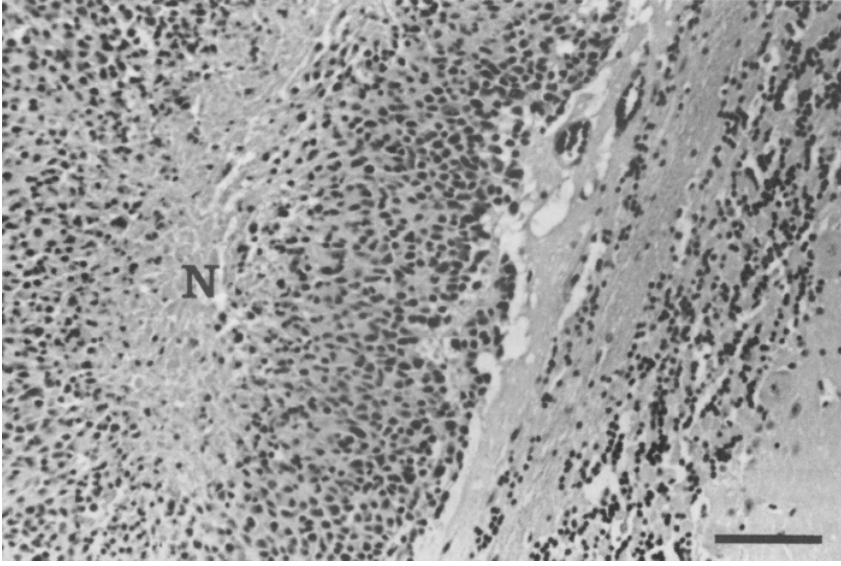
Fig. 2: Meningotheliomatous meningioma. Cerebellum. Neoplasm with central necrosis (N) on the left compressing the adjacent molecular layer with consequent demyelination and astrocytosis. Bar = 50 µ m. Haematoxylin and